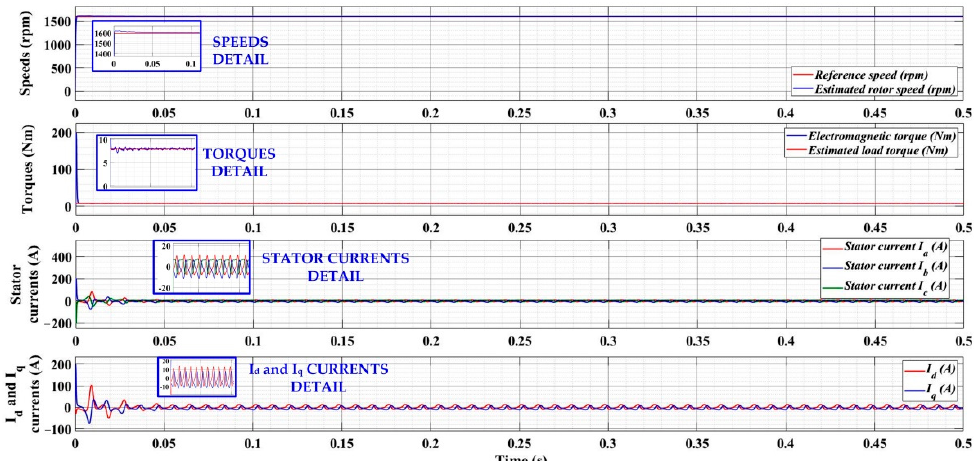
Figure 21. Time evolution for the numerical simulation of the PMSM control system based on the backstepping-PSO controller: ω ref = 1600 rpm, T L = 8 Nm, K ω = 0.01, K I ω = 140, K q = 5000, K Iq = 50, γ = 0.01, K d = 300, and K id = 300.